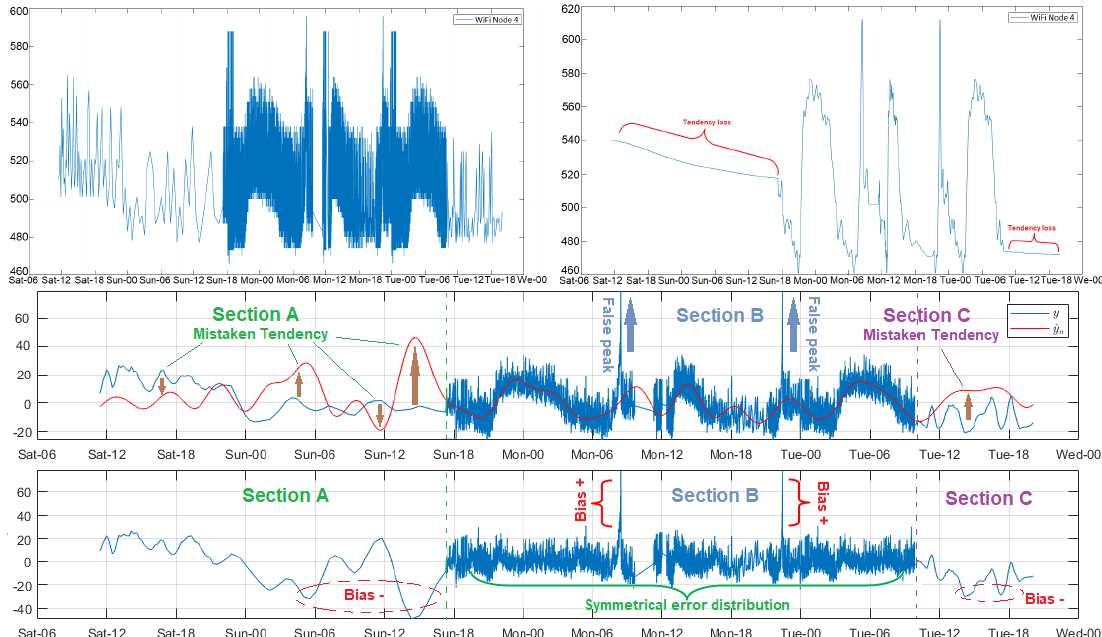
Figure 3. Modeling of CO 2 signal in Sensor Node 4 of WiFi network, with Reg = 15 and for different sampling rates. From top to bottom: the original signal ( left ); the filtered signal with Ord = 100 ( right ); the rhythmometric analysis; and the residual time evolution with Ord =